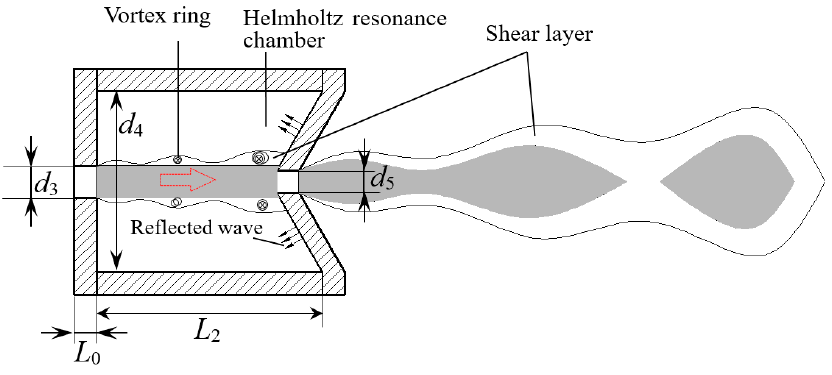
Figure 2. Structure diagram of a Helmholtz nozzle.